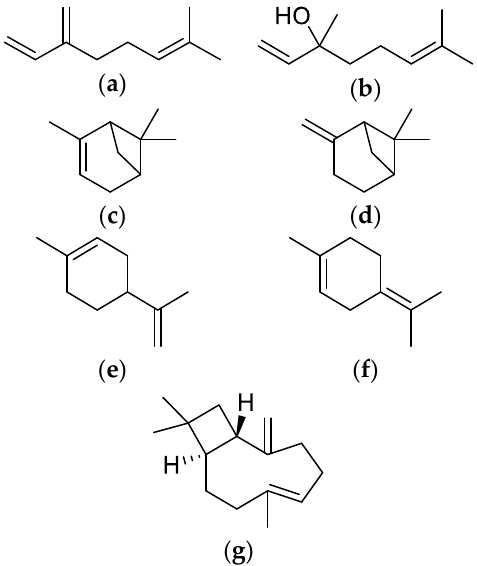
Figure 3. Chemical structures of major non-cannabinoid phytochemicals. ( a ) Myrcene; ( b ) Linalool; ( c ) α-Pinene; ( d ) β-Pinene; ( e ) Limonene; ( f ) Terpinolene; ( g ) β-Caryophyllene.